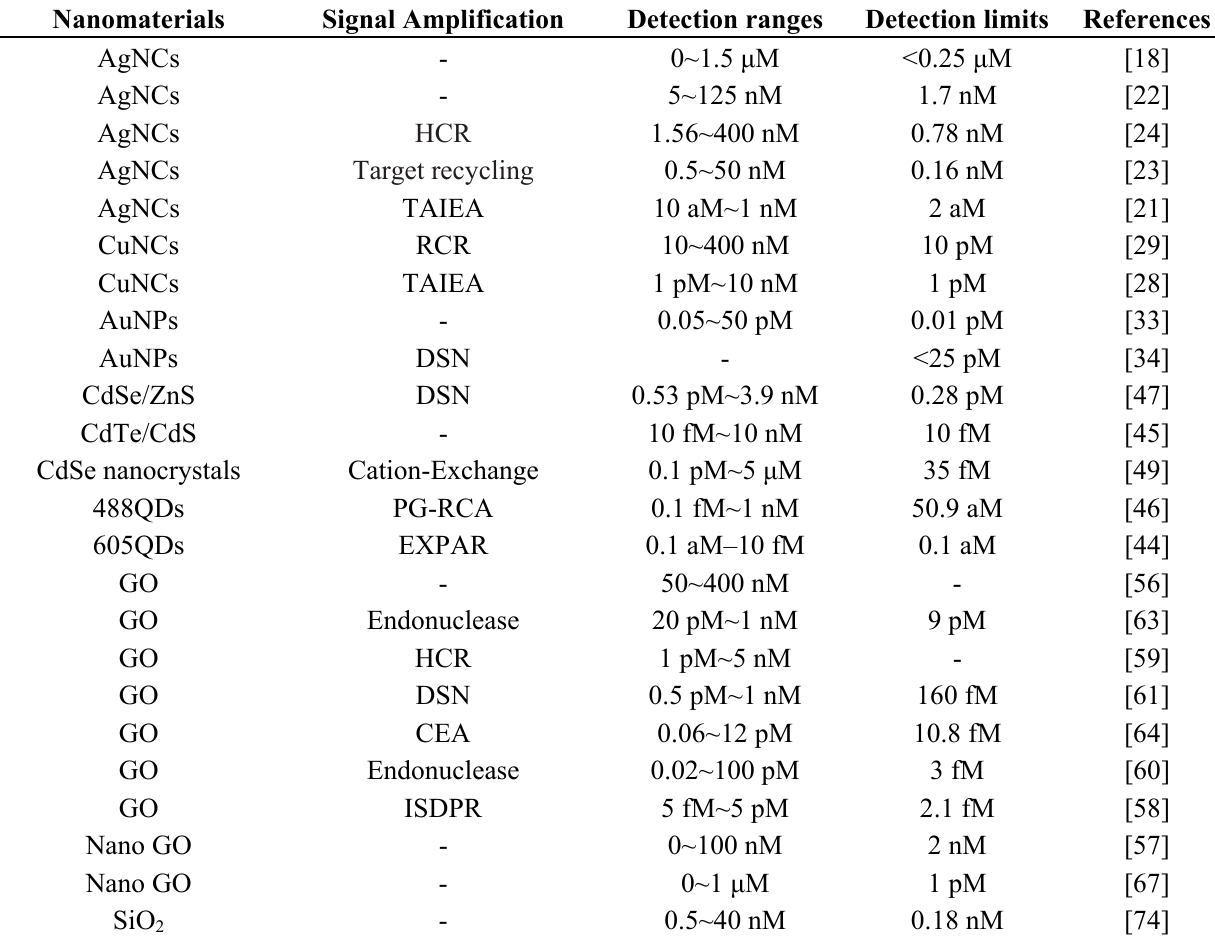
Table 1. Comparison of the performances of nanomaterials-based fluorimetric miRNAs biosensors.